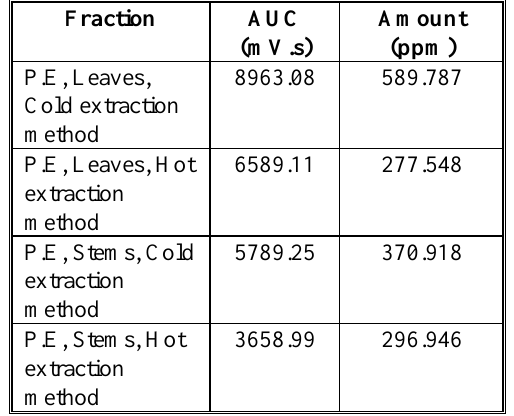
Table 8. Amount of lupeol in P.E extracted frac-